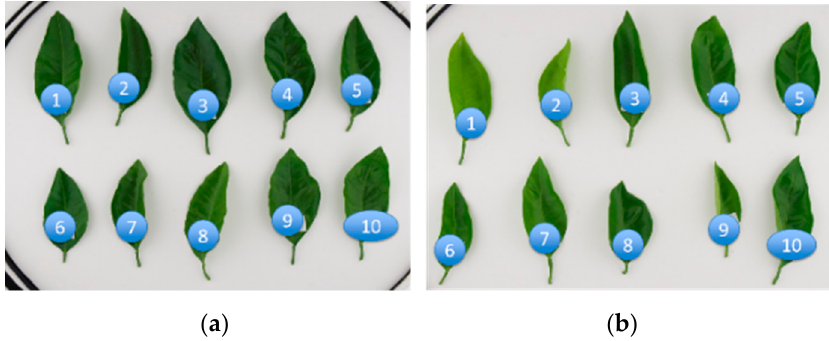
Figure 4. Sampled leaves: ( a ) Leaves of strong tree; ( b ) Leaves of weak tree.